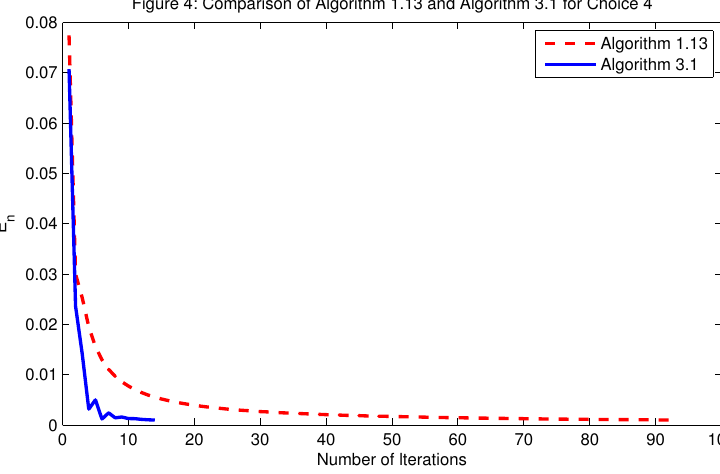
Figure 4: Comparison of Algorithm 1.13 and Algorithm 3.1 for Choice 4